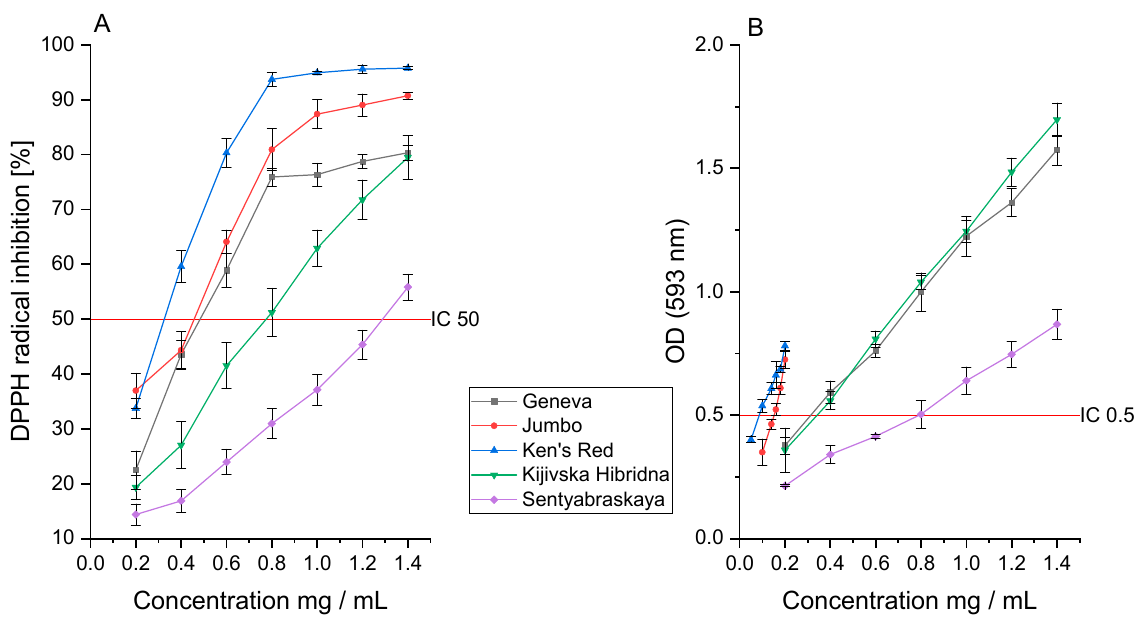
0.0 0.2 0.4 0.6 0.8 1.0 1.2